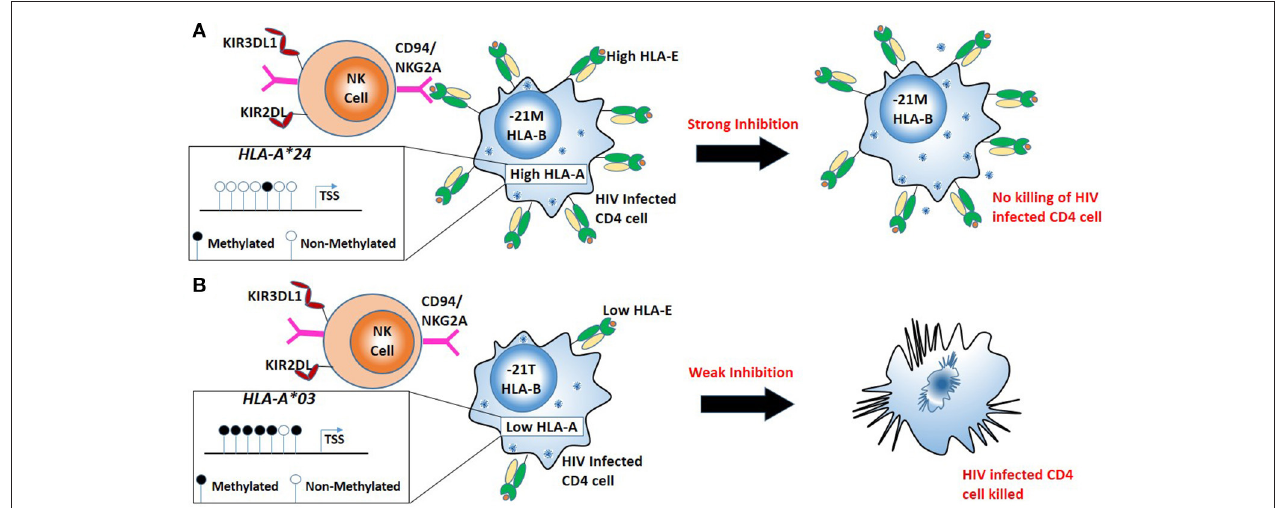
FIGURE 2 | Combination of high HLA-A allele expression and HLA-B alleles mediating in robust “licensing” of NK cells result in strong NK cell inhibition and result in poor HIV control. (A) Less promoter methylation results in a high expression HLA-A (e.g., HLA-A * 24 ). High HLA-A expression with the − 21M genotype at HLA-B leads to increased cell surface expression of HLA-E, robust NK cell licensing through CD94/NKG2A increased inhibition of NK cells. Strong inhibition of NK cells leads to escape of HIV infected cells from NK mediated killing. (B) High promoter methylation results in low expression of HLA-A (e.g., HLA-A * 03 ). Low expression HLA-A allele with − 21T genotype at HLA-B results in lower HLA-E on the surface resulting in little CD94/NKG2A licensing, NK cells mediated killing HIV infected